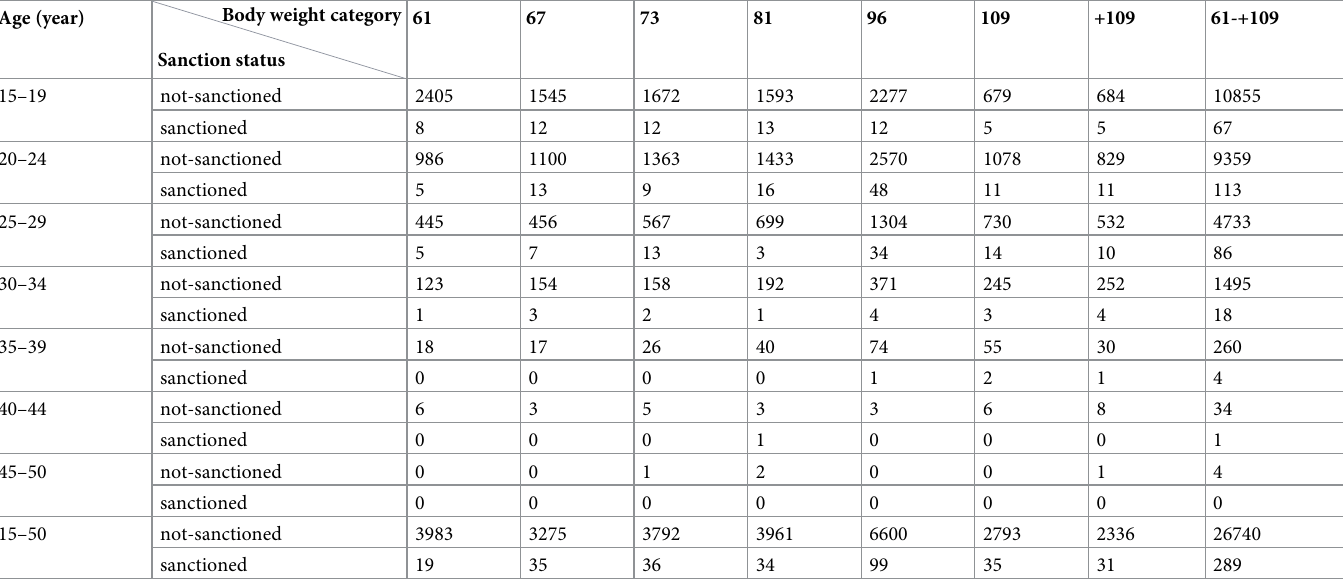
Table 1. Number of datasets obtained for the study.